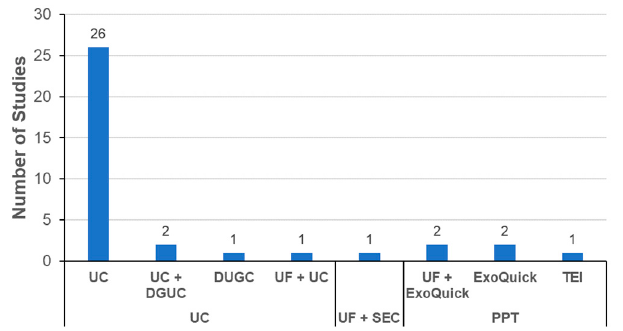
Figure 5. Isolation methods of exosomes in literature of exosome biodistribution.